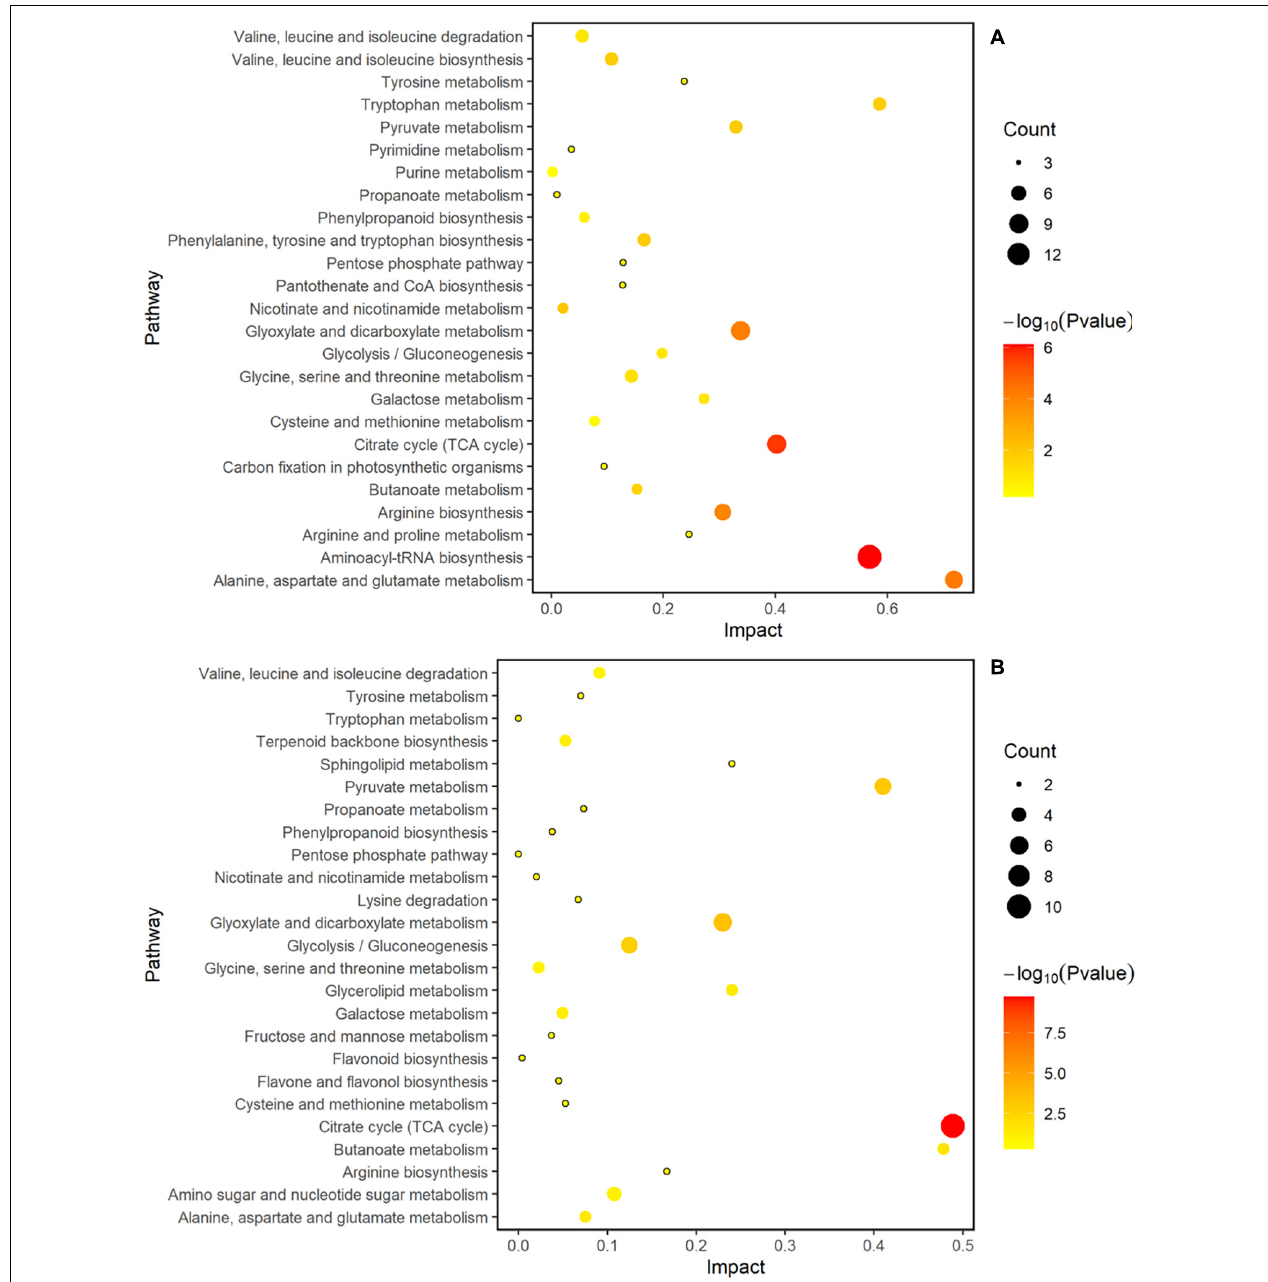
FIGURE 10 | Analysis of metabolic pathways of TLP-DN3 and TS-DN3. Results were from the analyses using the MetaboAnalyst 4.0 software. Every circle represents a metabolic pathway, with red color indicating higher impact and yellow color indicating lower impact. The pathways with p -value < 0.05 were determined to have significant changes. The size of the circle represents the number of DEMs participating in the pathway. (A) Rice samples of DN3 at the TLP, (B) rice samples of DN3 at the